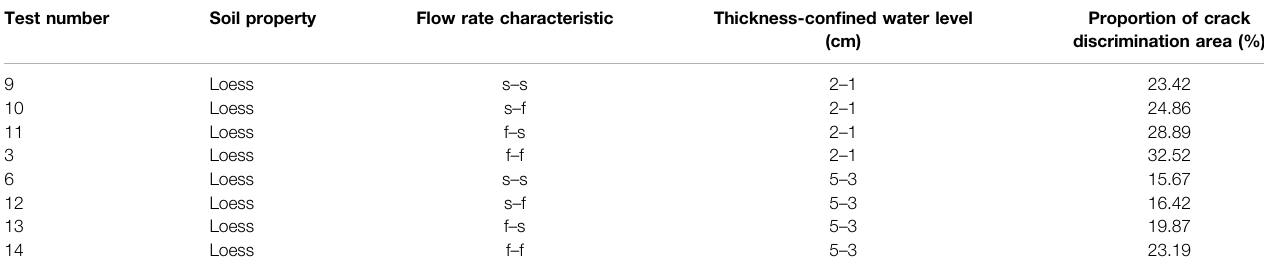
TABLE 4 | Proportion of the crack discrimination area in the binary